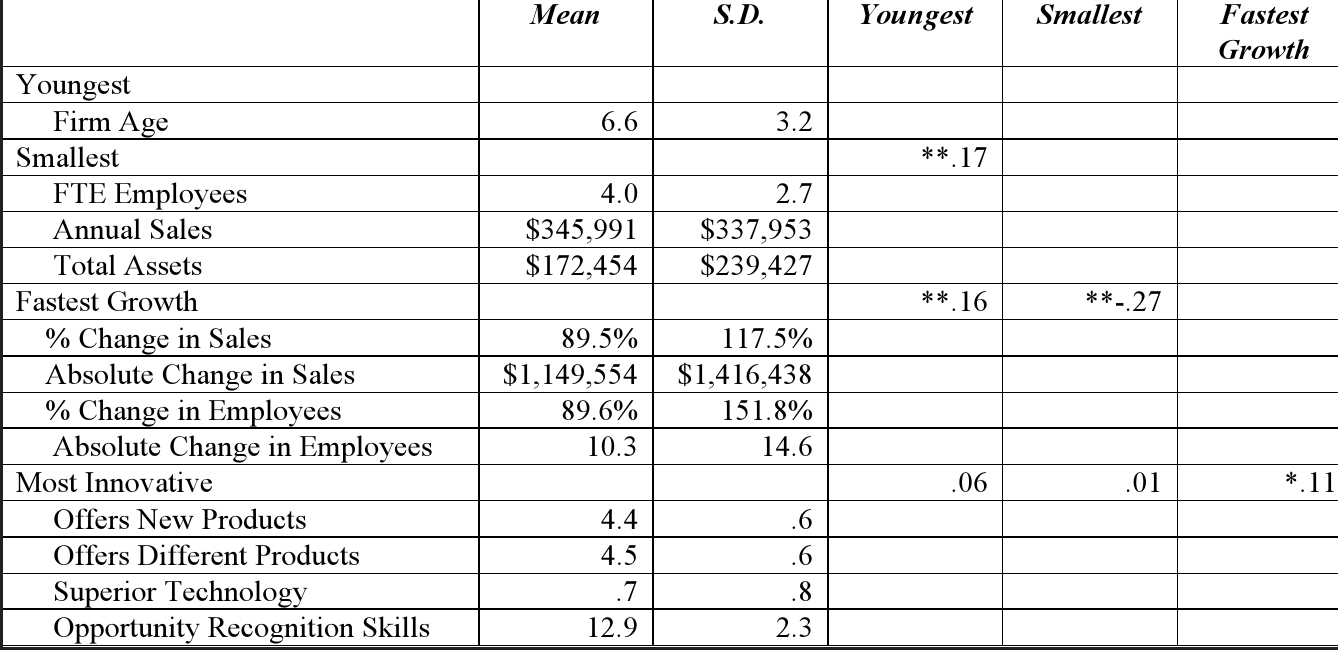
*Searched for “small firm,”“small venture,” and “small enterprise.” Table 2. Descriptive Statistics of the Subsamples and